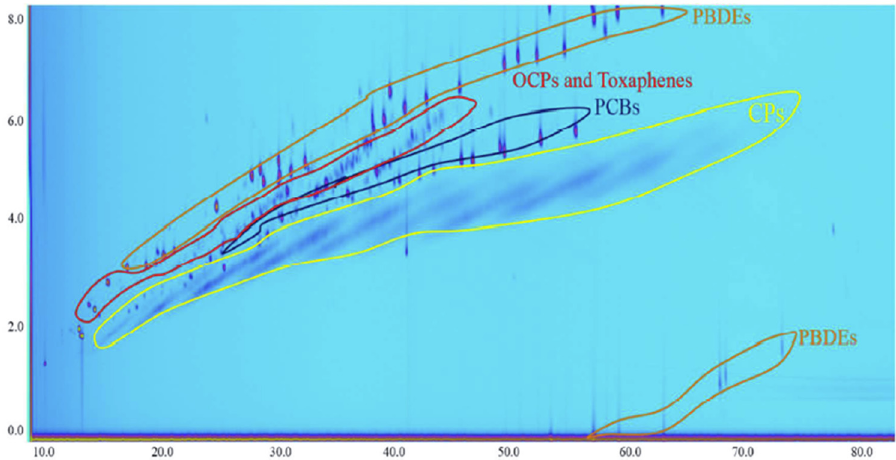
Figure 2: GC × GC - ECNI - HRTOF - MS TIC chromatograms of a mixture of 27 OCP congeners, 39 PBDE congeners, 72 PCB congeners, and technical toxaphenes, technical SCCPs ( 51.5% Cl ) , and technical MCCPs ( 57% Cl ) . The resolution o ff ered by GC × GC allowed the CPs to be clearly separated from the other classes of compounds in the full scan mode [ 48 ]